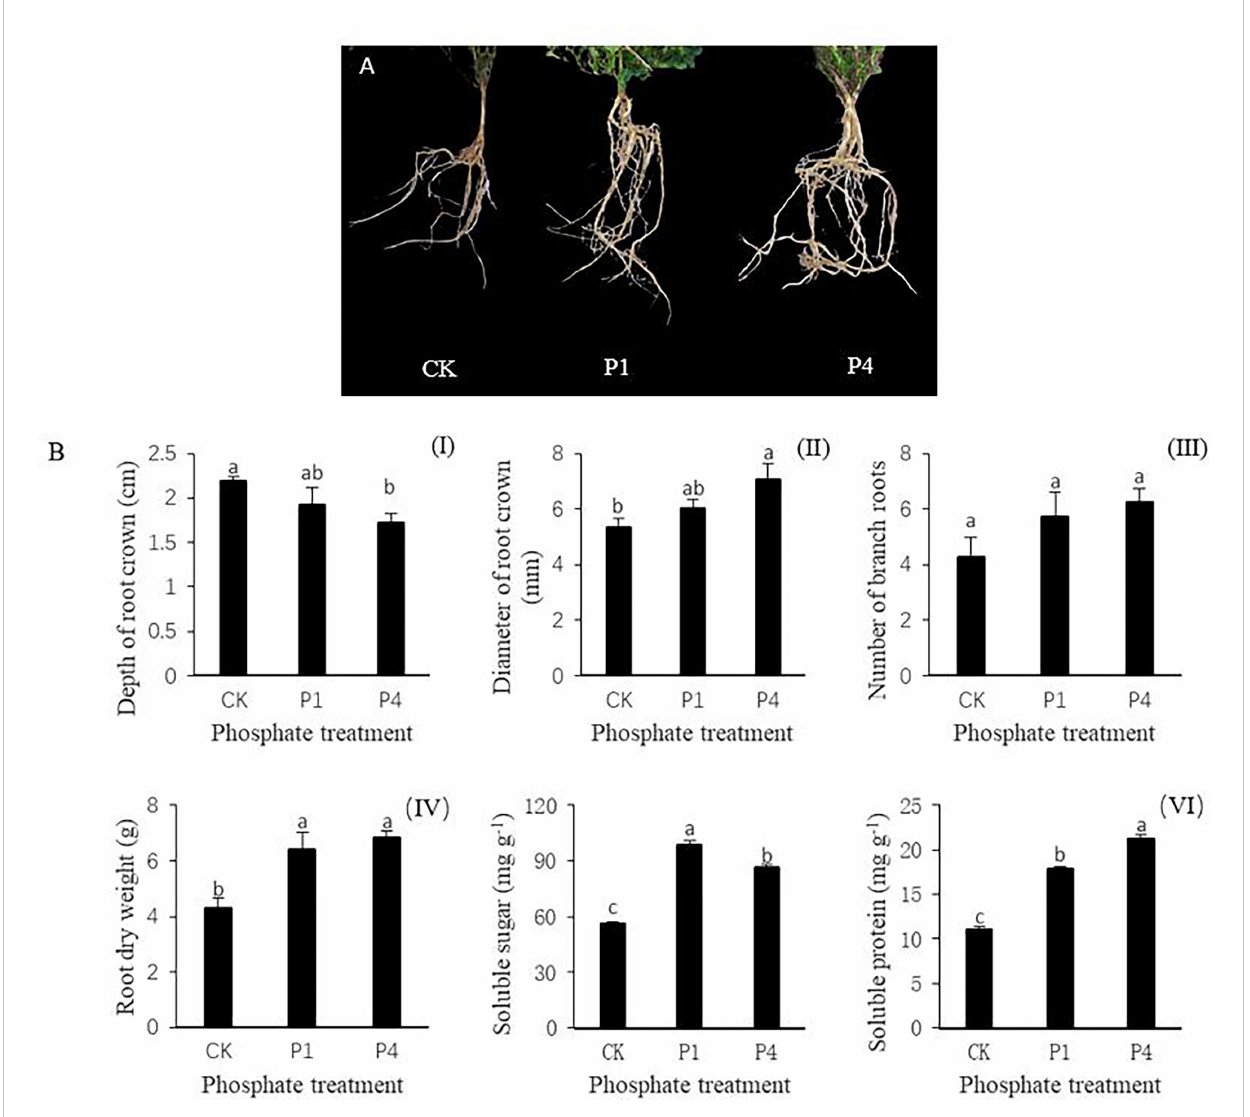
FIGURE 1 The responses of alfalfa phenotypic and physiological indices to phosphate (P) application under low temperature. (A) Alfalfa roots exposed to P application showed improved root growth. (B) Changes in the morphological and physiological indices of alfalfa roots, including (I) the depth of the root crown into the soil surface, (II) the diameter of the root crown, (III) the number of branch roots, (IV) root dry weight, (V) soluble sugar, and (IV) soluble protein. Values labeled with different lowercase letters indicate a signi fi cant difference between the P treatments at P < 0.05. CK, P1, and P4 represent 0, 50, and 200 P 2 O 5 mg kg -1